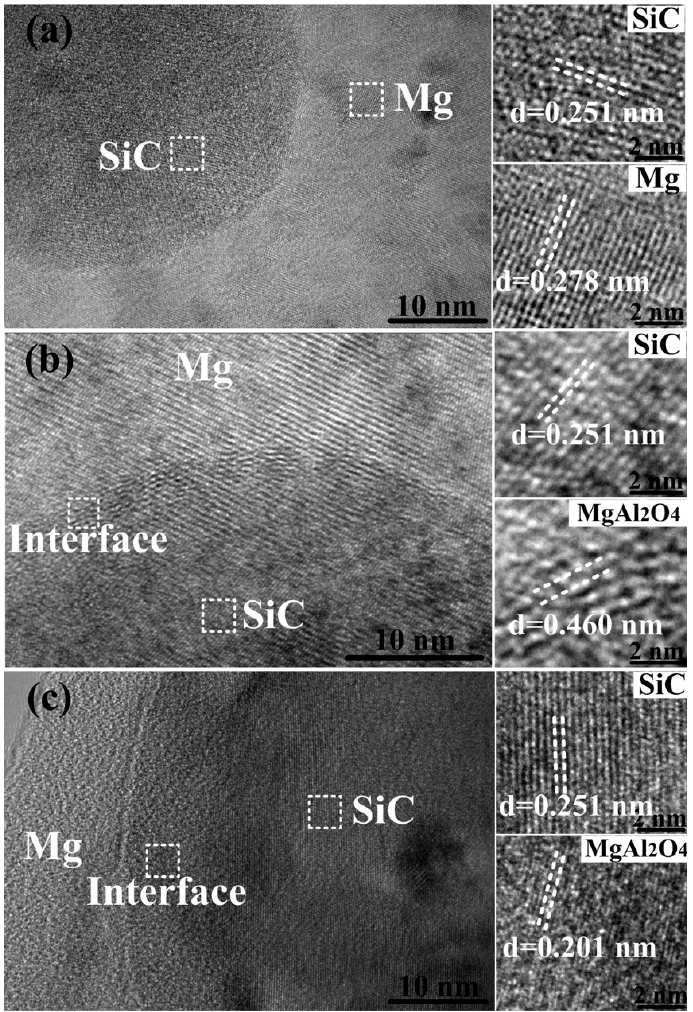
Figure 6. HRTEM images of 0.5 vol % n-SiC p /AT81 composites reinforced by: ( a ) untreated; ( b ) 1073 K/2 h; and ( c ) 1273 K/2 h treated n-SiC p .